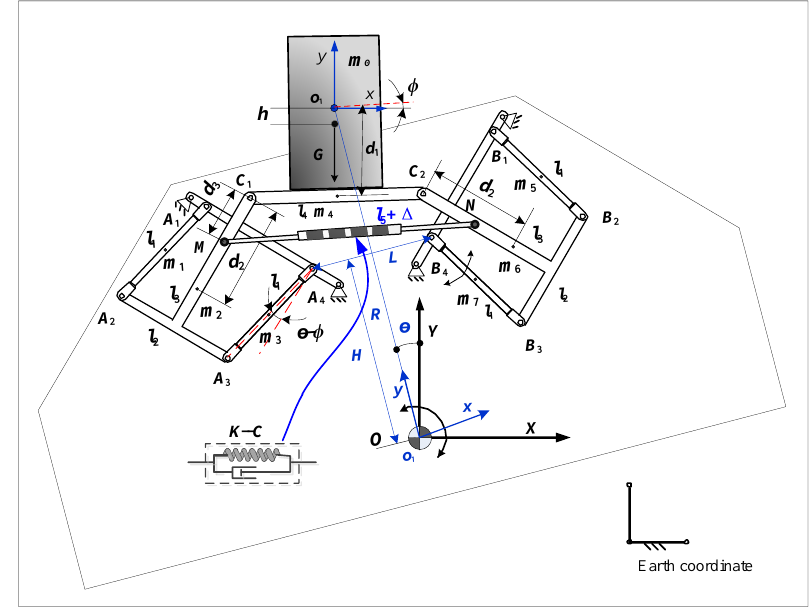
Figure 2. Motion diagram of the dual-parallelogram vibration isolation.